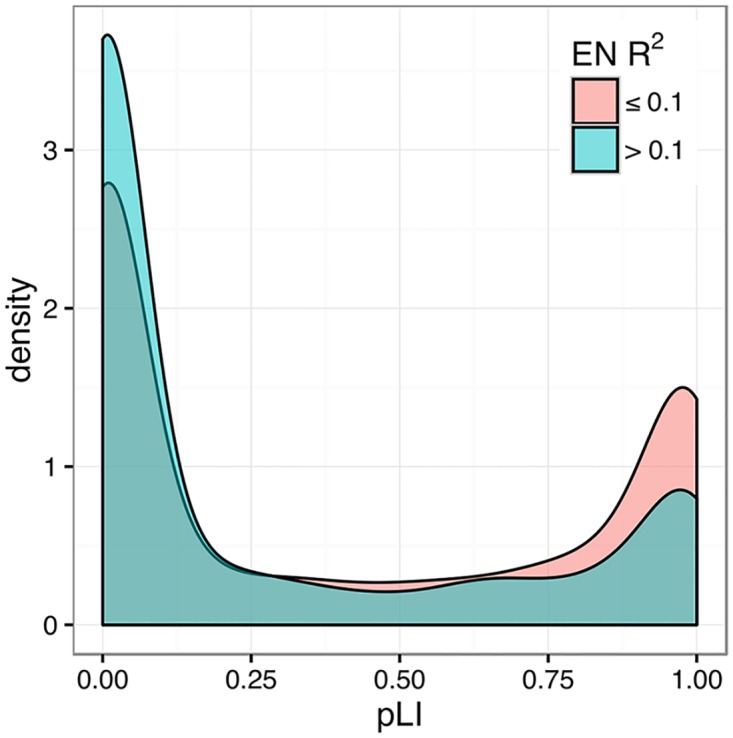
Genes with heritable expression in DGN whole blood are more tolerant to loss of function mutations.The distribution of the probability of being loss-of-function intolerant (pLI) for each gene (from the Exome Aggregation Consortium [32]) dichotomized by local heritability estimates. The Kruskal-Wallis rank sum test revealed a significant difference in the pLI of heritability groups (χ2 = 234, P < 10−52). More heritable genes (h2 > 0.1 in blue) have lower pLI metrics and are thus more tolerant to mutation than genes with lower h2.